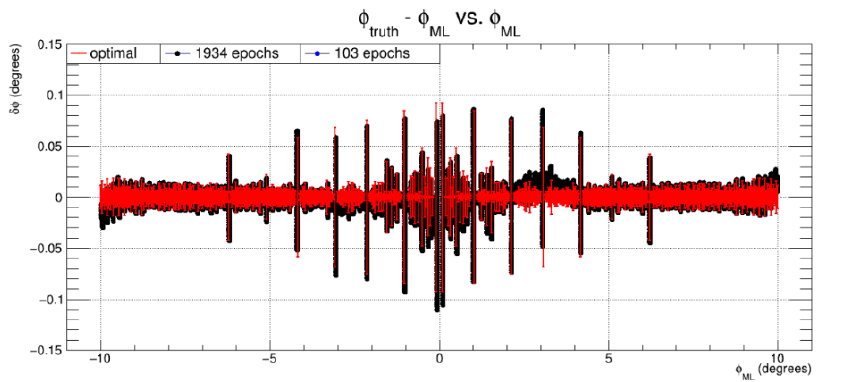
Figure 3. The di ff erence between inference and truth versus the predicted value which shows how the di ff erence is dependent on track angle and that the model faithfully reproduces this dependence.